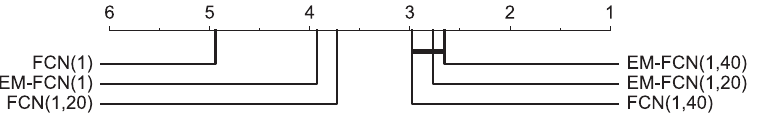
Figure 10. The critical difference diagram of a pairwise statistical difference comparison of EM-FCN and FCN with different kernel